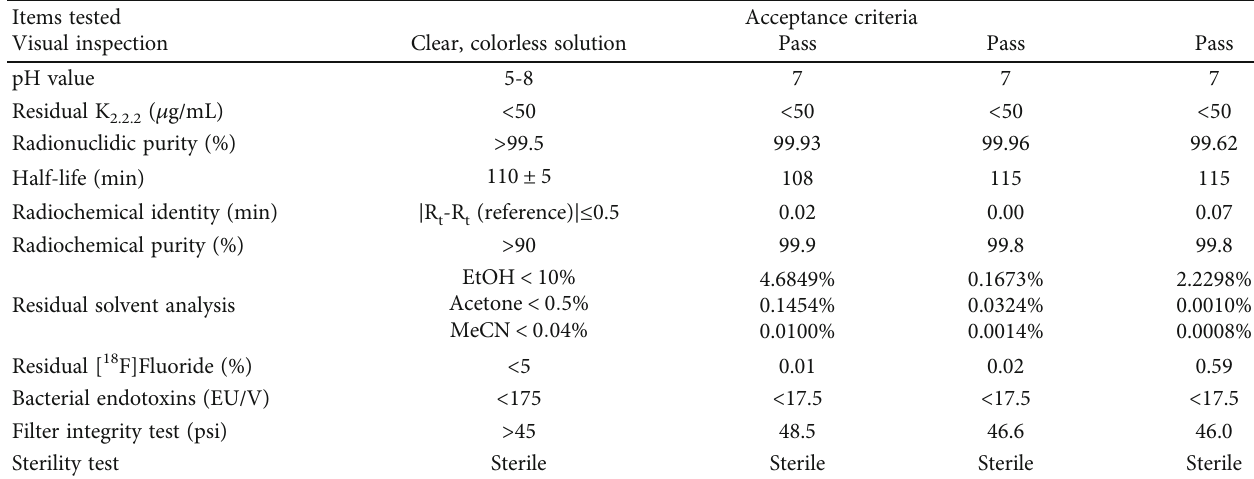
Table 1: The QC tests of the [ 18 F]FEPPA